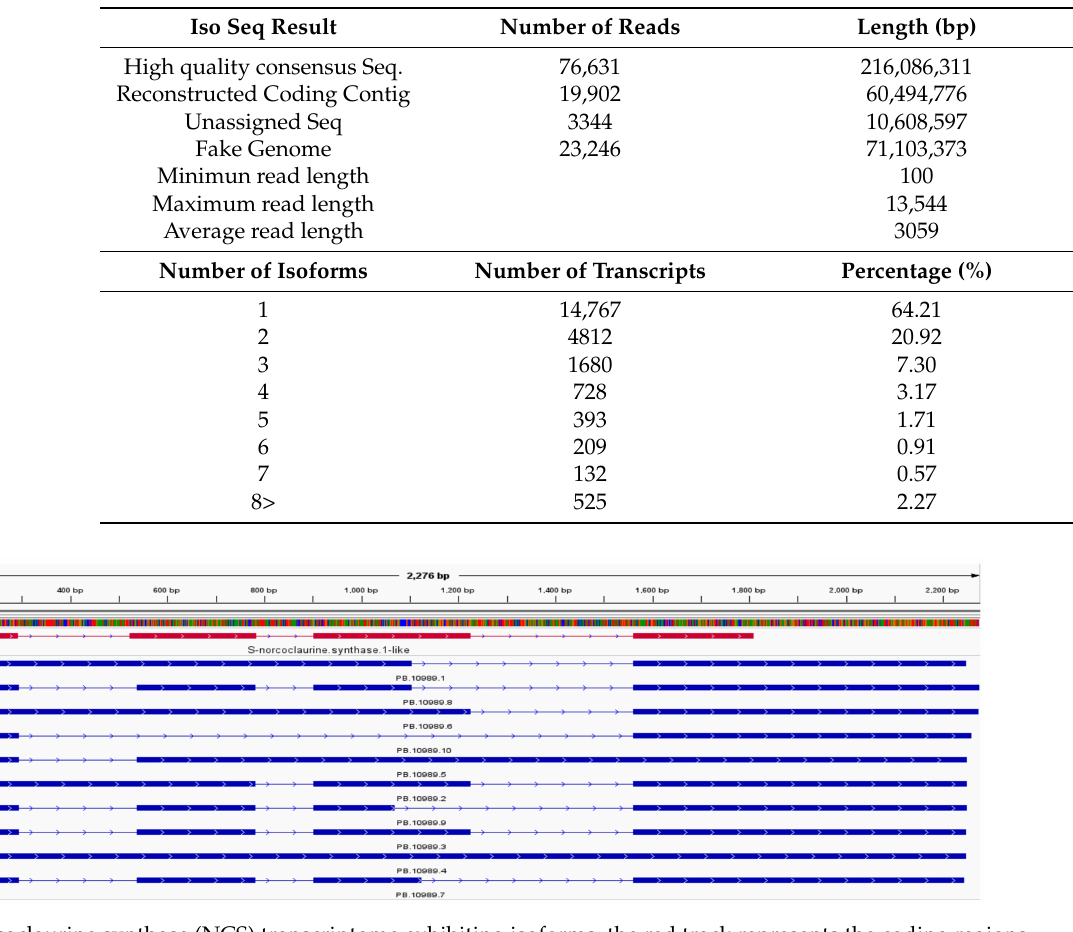
Table 2. Isoseq result and isoform number.